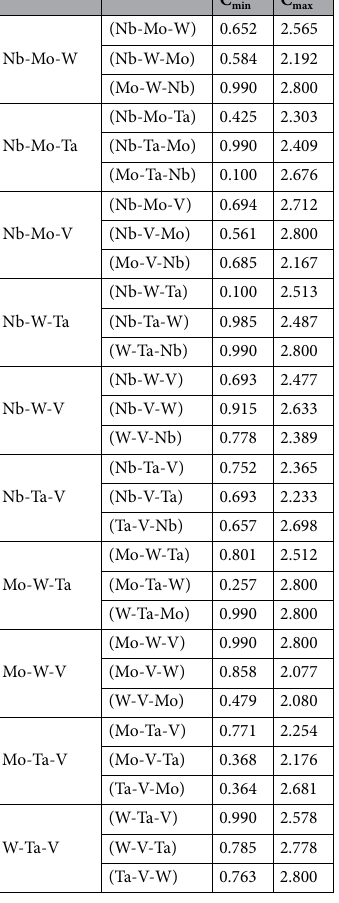
the element type, grain and grain boundary atoms identified by the common neighbor analysis (CNA) 35 , and the grain identity number, respectively. Table 4 summarize the grain number and total atom num- ber of the Nb